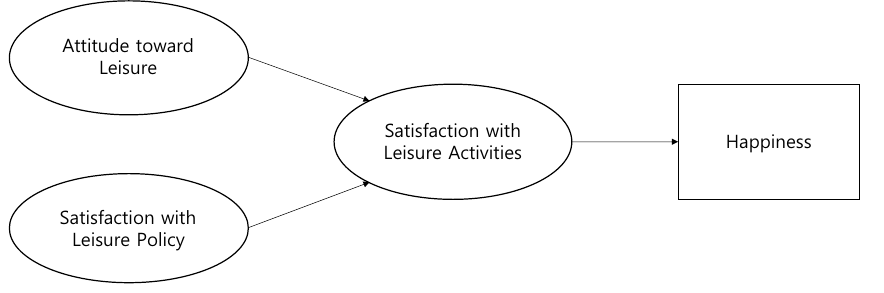
Figure 1. Path diagram of the hypothesized